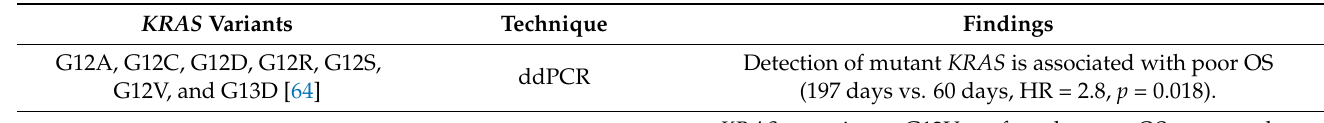
Table 2. Summary of studies determining prognostic value KRAS mutations in